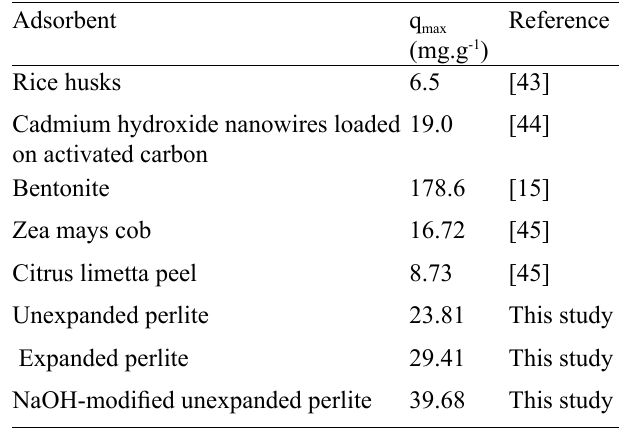
Table 5. Adsorption uptakes of some low cost adsorbents for MG